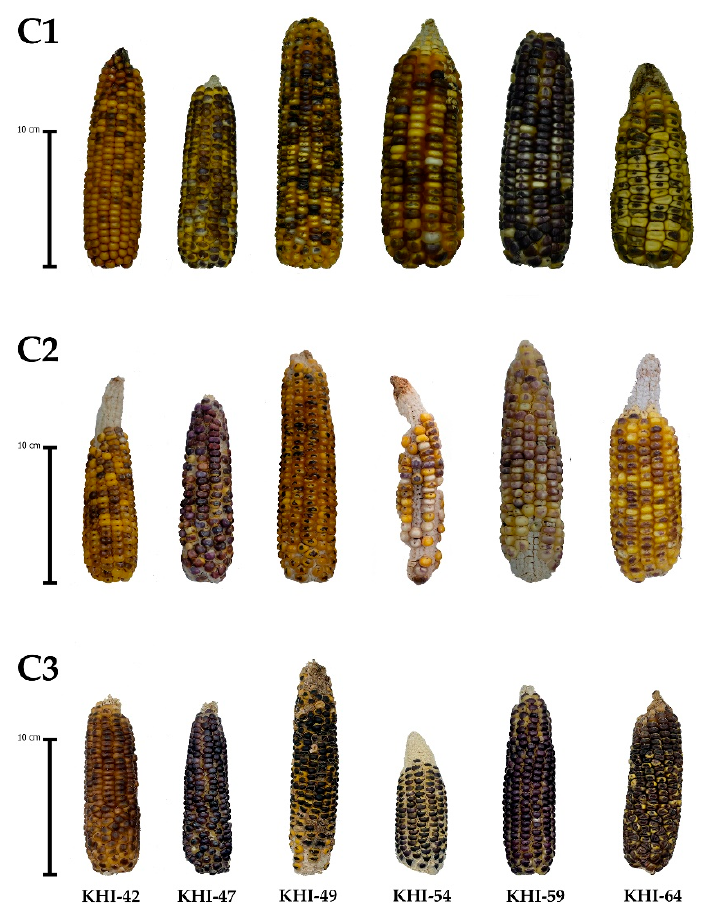
Figure 6. Representative corn ears of six families of putative tropical haploid inducer showing positive responses to three breeding cycles on inducer seed set and R1-nj anthocyanin expression (C1, C2, and C3 represent breeding cycle 1, cycle 2, and cycle 3).